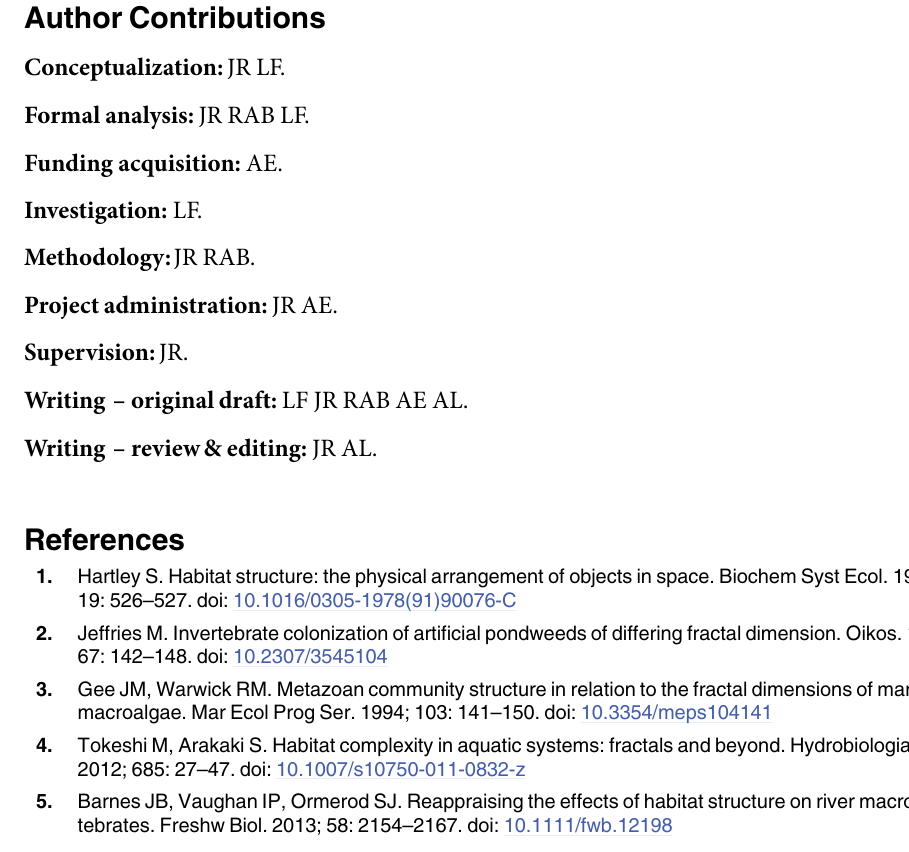
S1 Table. Data. An overview of predictors and responses. S2 Table. CollectionB ANOVA additional analyses. pH was measured throughout the exper- iment and ‘amount’ significantly influenced this response. Two examples are given here in the original R output. Comparing this to Table 2 shows how the ANOVA table was